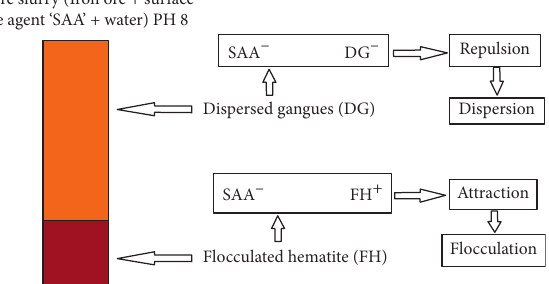
Figure 14: Model diagram for the overall